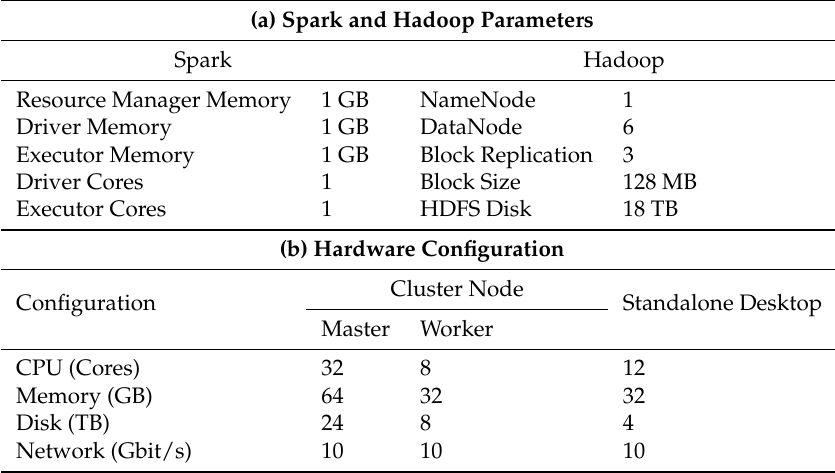
Table 4. Hardware and Cluster Parameters and